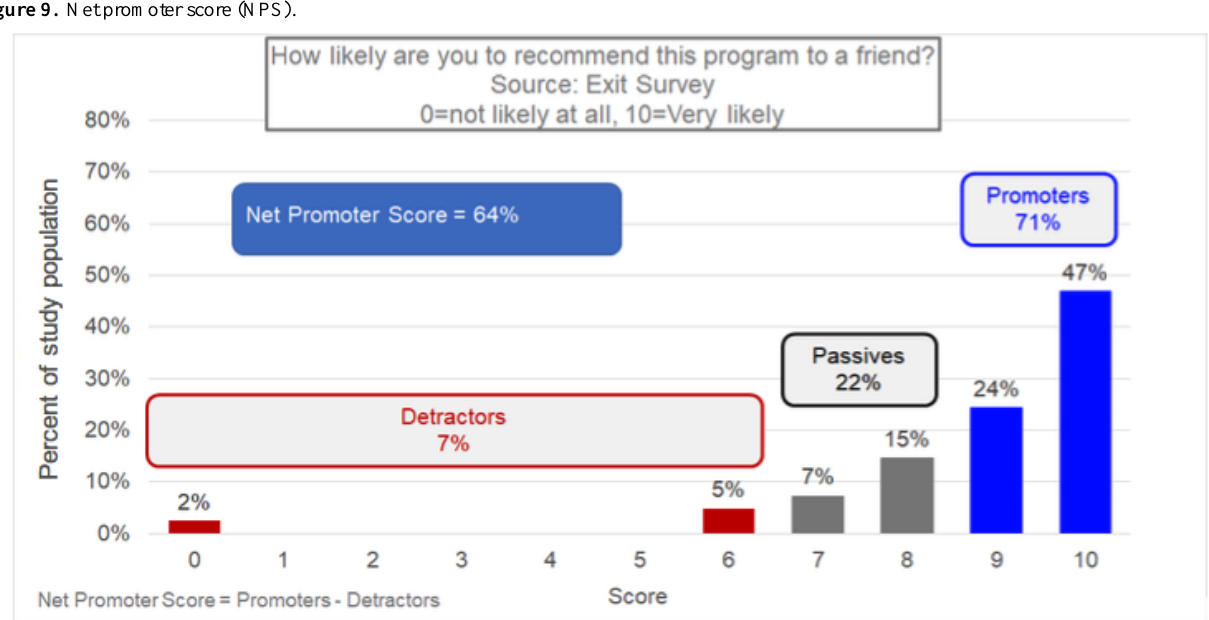
Figure 9. Net promoter score